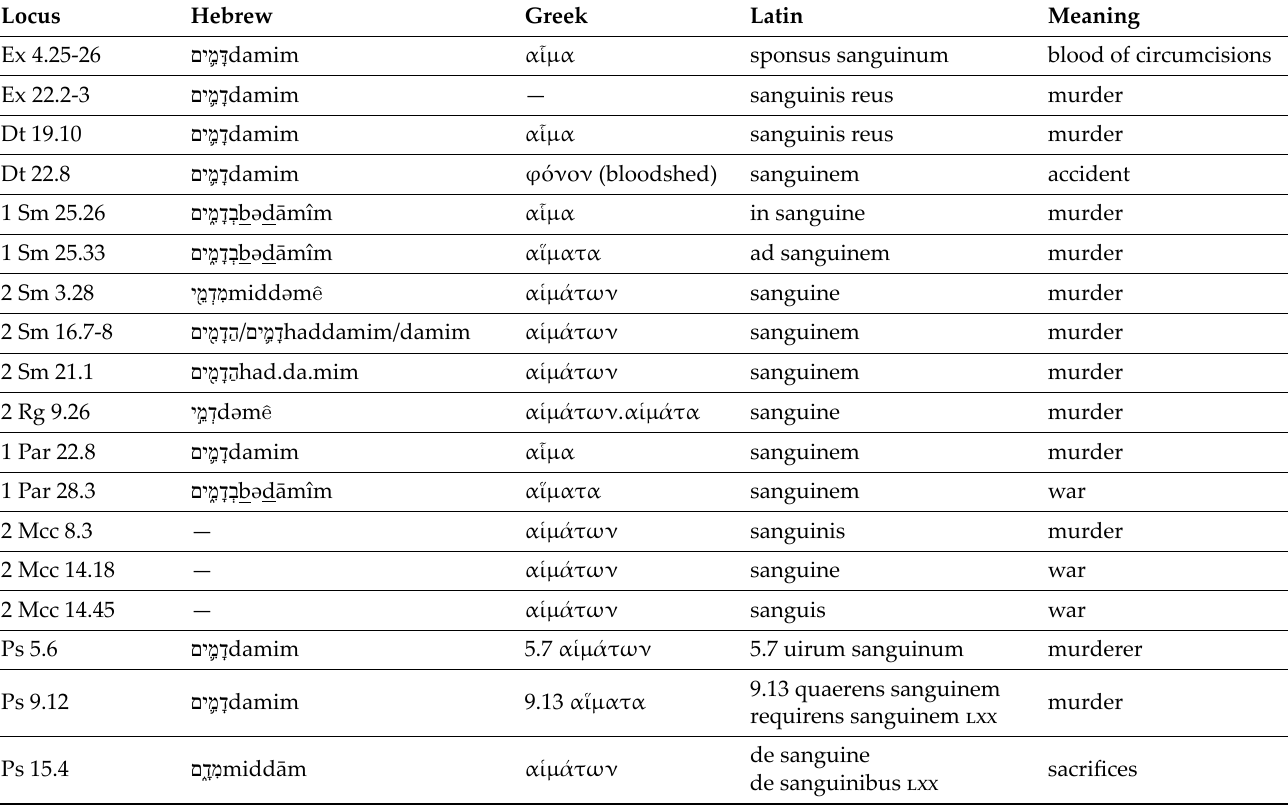
Table A1. Table of the Biblical